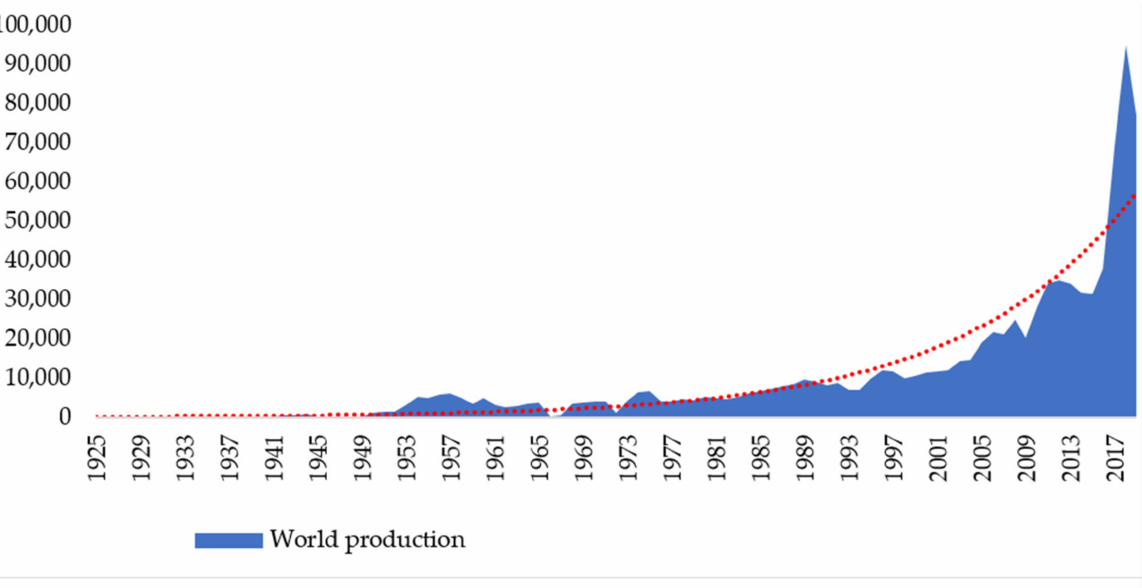
Figure A2. Global mine production of Li per thousand tons (build on the data from [25]), the red line is a